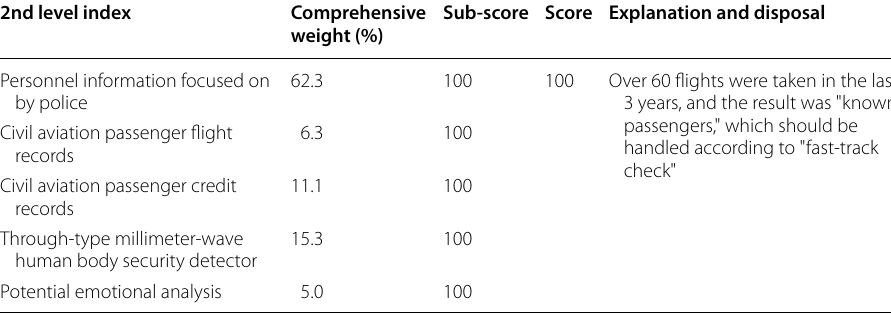
Table 11 Risk assessment results and disposal methods of case 1